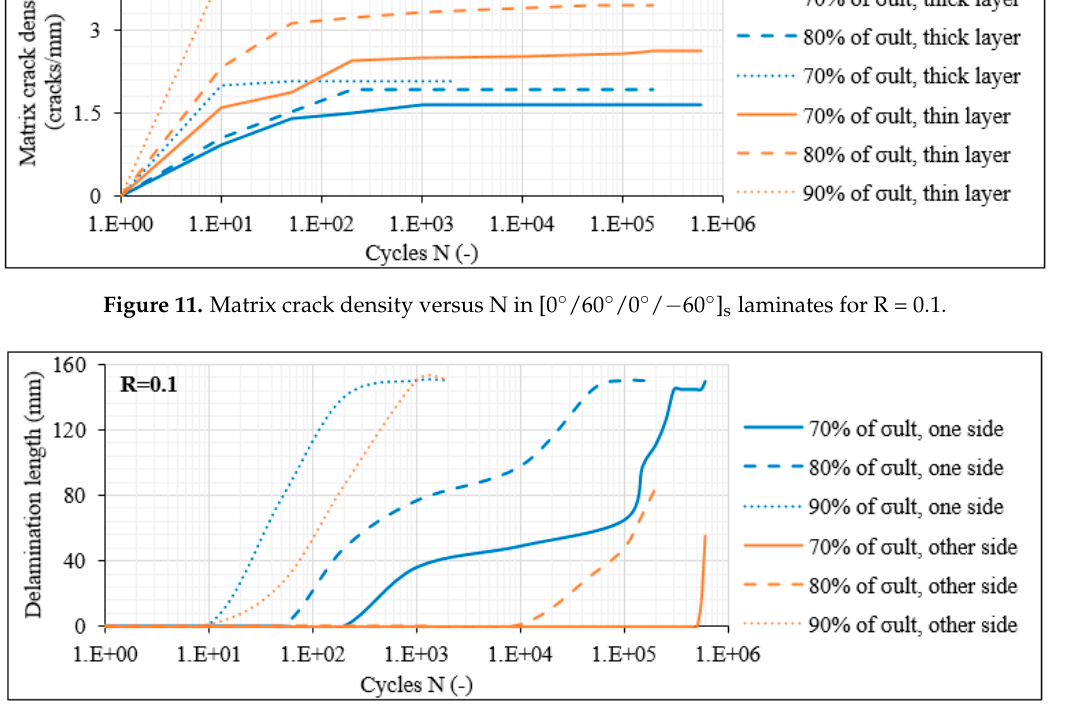
Figure 12. Delamination crack growth versus N in [0°/60°/0°/ − 60°] s laminates for R = 0.1.